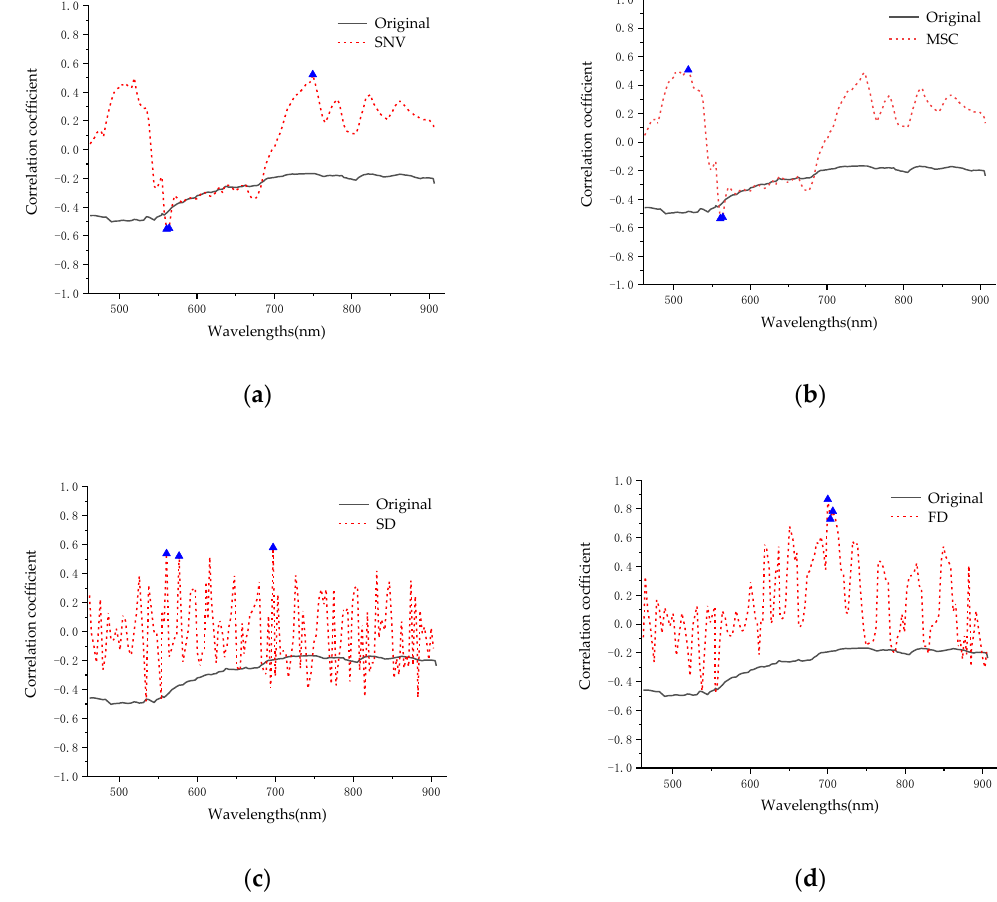
Figure 4. Variation of the correlation coe ffi cients after the di ff erent preprocessing. ( a ) SNV; ( b ) MSC; ( c ) SD; ( d )